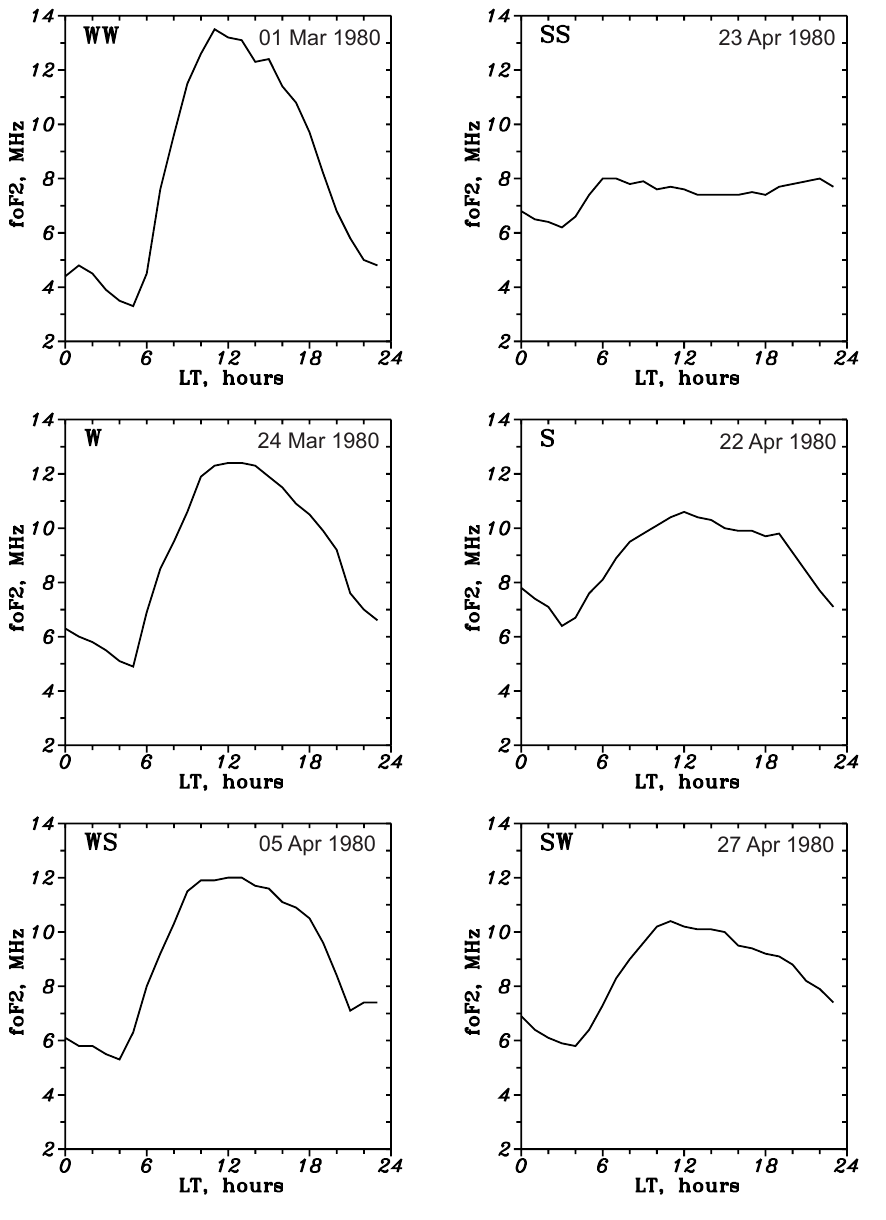
Fig. 1. Typical winter- and summer- type diurnal fo F2 variations observed at Moscow in 1980 and used to specify the dates of winter/summer transitions.